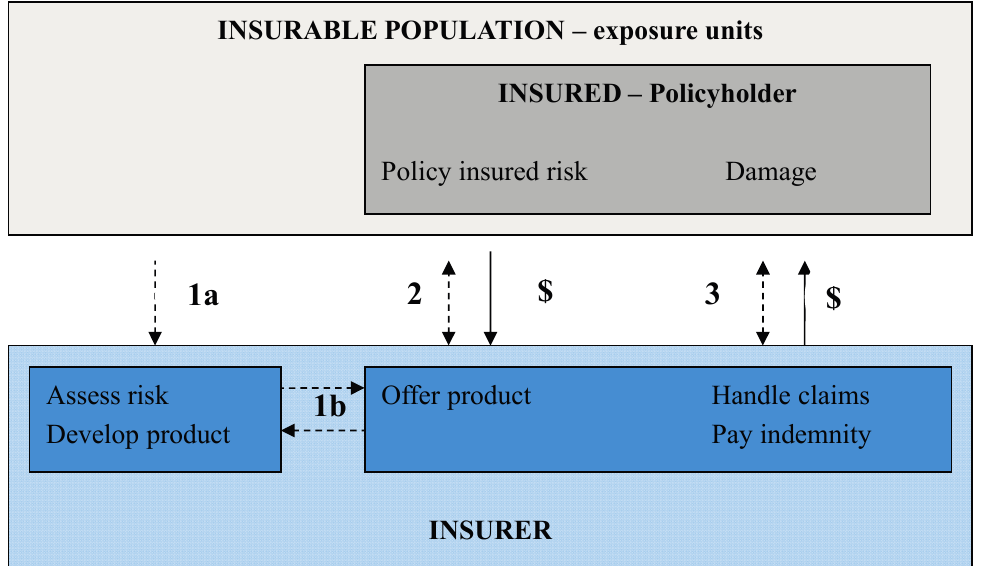
Figure 1. Business processes (blue) including financial transactions ($) and information flows (numbered) between insurers and their clients in claim-based